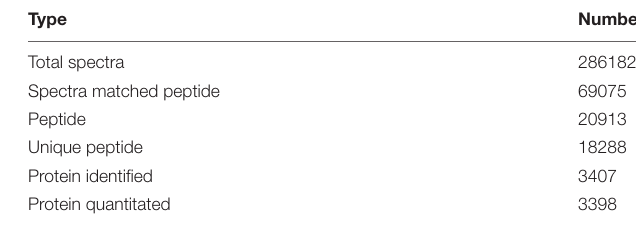
TABLE 2 | Results of